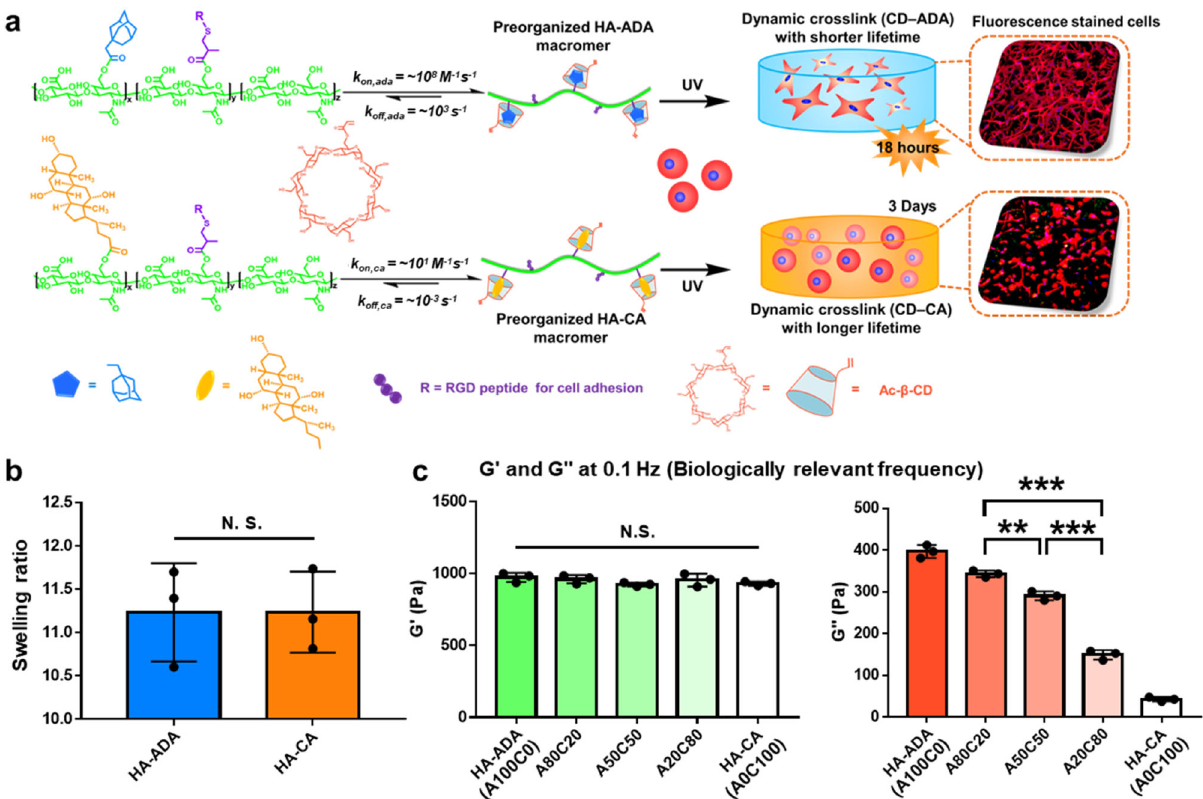
Fig. 1 The supramolecular hydrogels stabilized by reversible host – guest crosslinks with different binding kinetics possess differential dynamic properties. a Schematic illustration of the preparation of supramolecular hyaluronic acid hydrogels stabilized by different pairs of host – guest complexation (cyclodextrin – adamantane/cyclodextrin – cholic acid or CD – ADA/CD – CA) and the monitoring of 3D spreading of encapsulated hMSCs. b The swelling ratio of hydrogels measured after incubating in culture medium for 3 days. Data are presented as mean values ± SD (standard deviation), n = 3 independent hydrogels per group, N.S. indicates no statistical difference. (two-tailed Student ’ s t -test). c Average value of G ′ and G ″ from rheological analysis at the frequency of 0.1 Hz and 1% strain. Data are presented as mean values ± SD, n = 3 independent hydrogels per group, N.S. indicates no statistical difference (ANOVA), ** p < 0.01, *** p < 0.001 (two-tailed Student ’ s t -test) (A80C20, A50C50, A20C80 were prepared by mixing HA – ADA and HA – CA at the